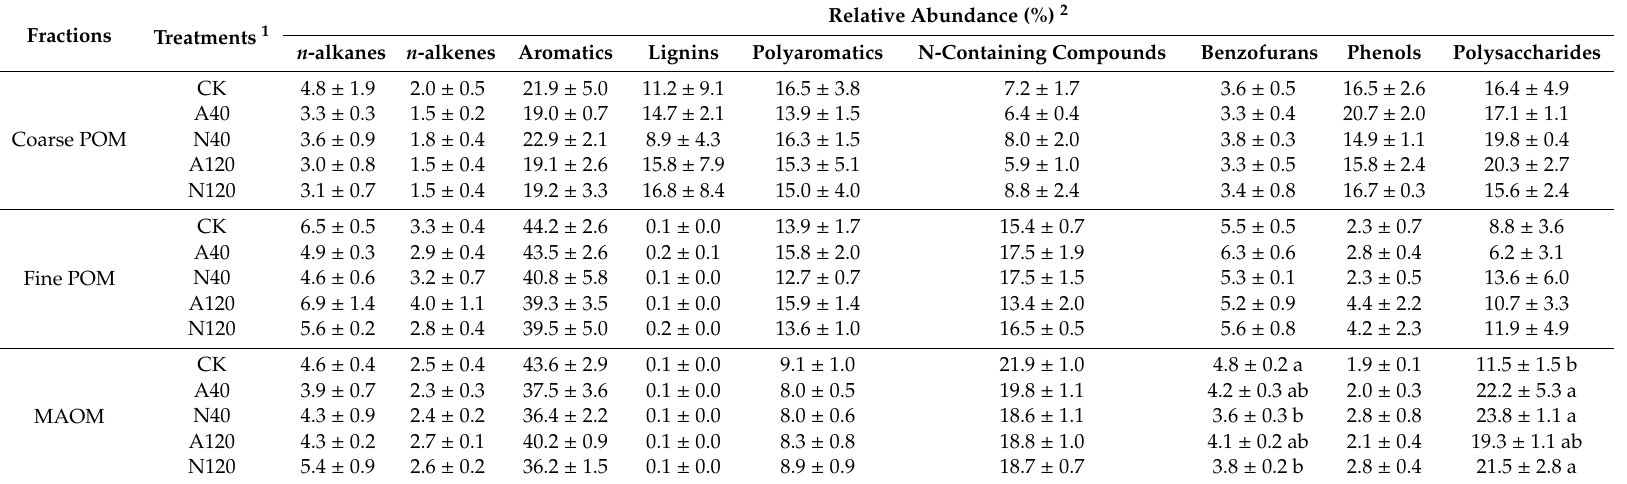
Table 2. Relative abundance of chemical groups in three fractions under di ff erent